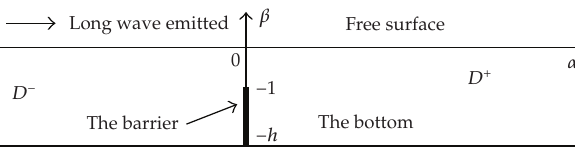
Figure 2: Domains D (cid:9) and D −